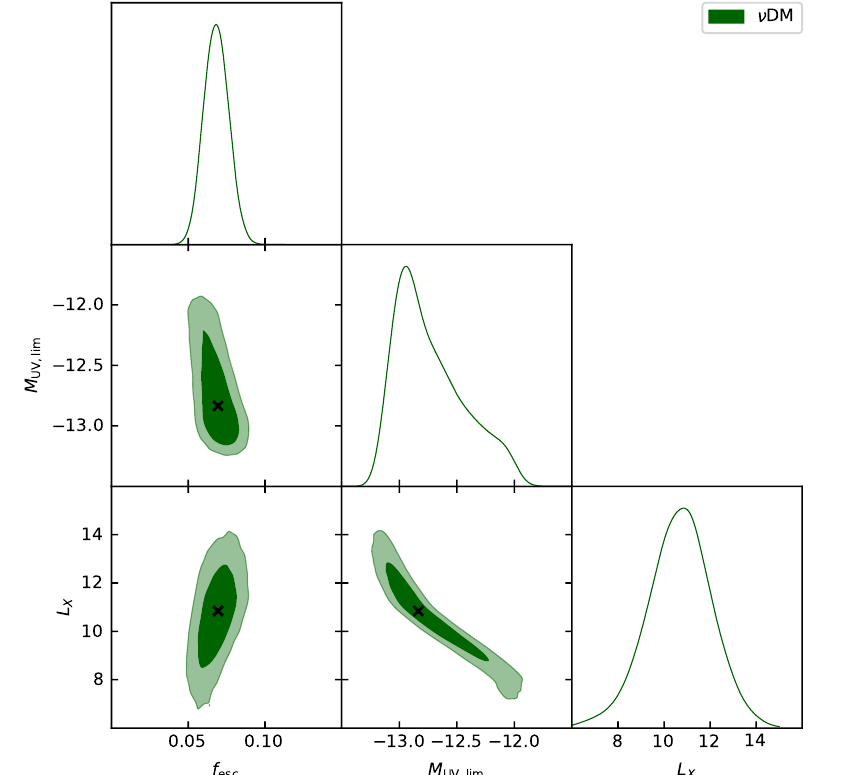
Figure 9. MCMC posterior distributions in the ν DM scenario (sterile neutrino DM with a mass of 7 keV), for the escape fraction f esc of ionizing photons, the limiting UV magnitude M UV,lim , and the lepton asymmetry parameter L X . The contours show 68% and 95% confidence intervals, the black cross shows the maximum likelihood position, and the marginalized distributions are in arbitrary units (normalized to 1 at their maximum value). Table 3. Marginalized posterior estimates of the parameters from the MCMC analysis for the different DM scenarios considered in the main text. Specifically, f esc is the escape fraction, M lim UV magnitude, and the astroparticle quantity X in the third column stands for: m X is in units of keV for WDM scenario, m X in units of 10 − 22 eV for the ψ DM scenario, T X in units of keV for the SIDM scenario, and L X for the ν DM scenario. Mean and 1 σ confidence limits are reported. The last column refers to the value of the Bayes information criterion (BIC) for model comparison, see Section